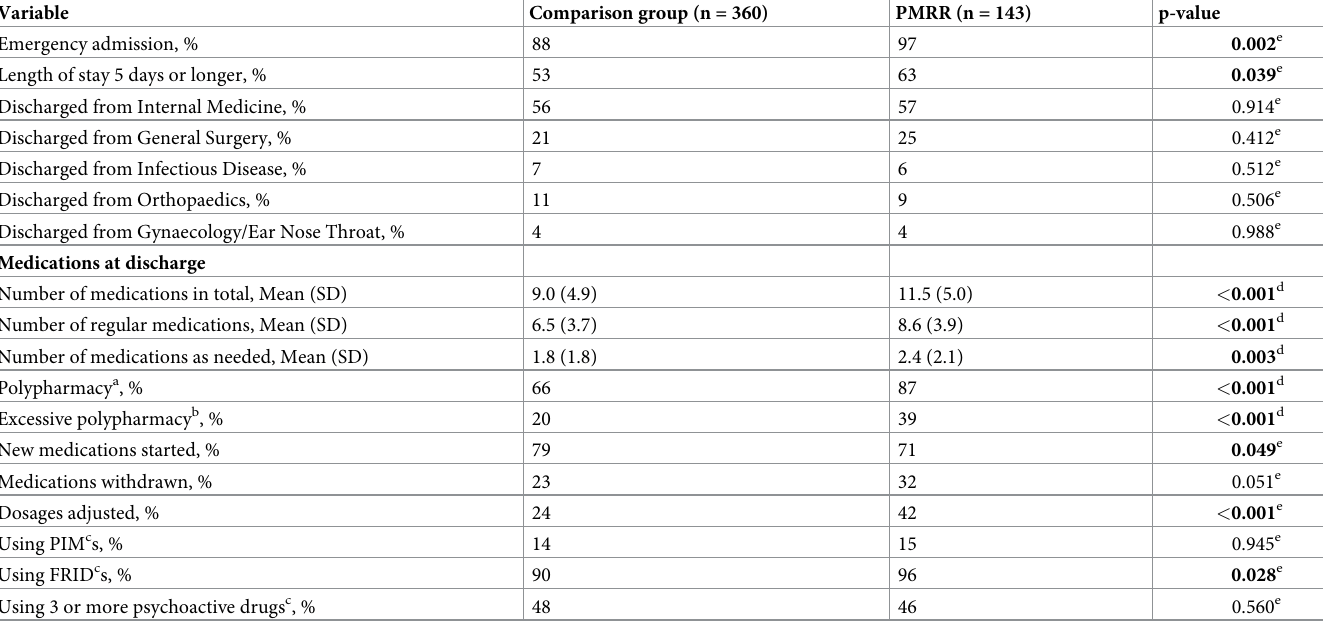
Table 2. Variables related to initial hospital stay and discharge.